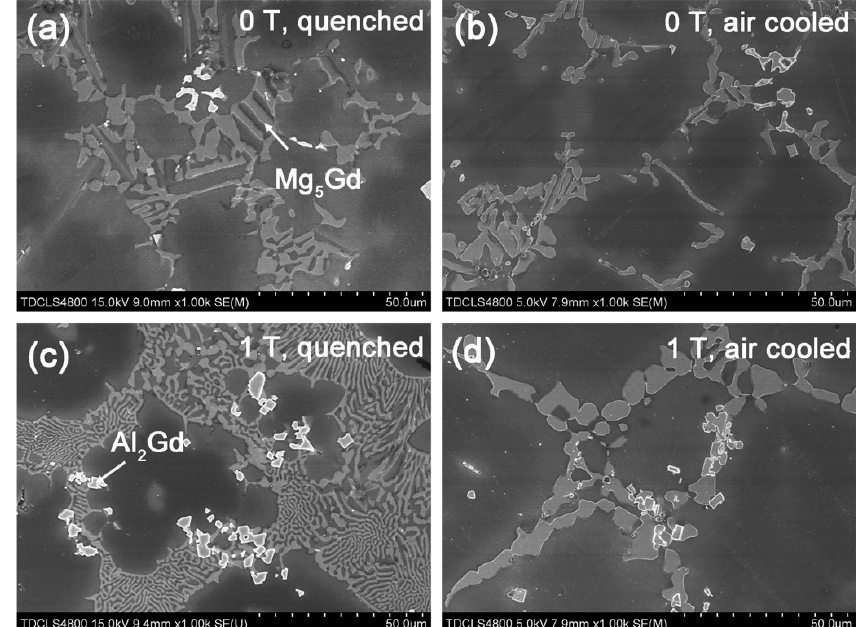
Figure 8. SEM images of the ( a ) quenched and ( b ) air ‐ cooled Mg–Al–Gd alloys under 0 T, and (c) 1 T, and the air ‐ cooled alloys under ( c ) 0 T and ( d ) 1 T.